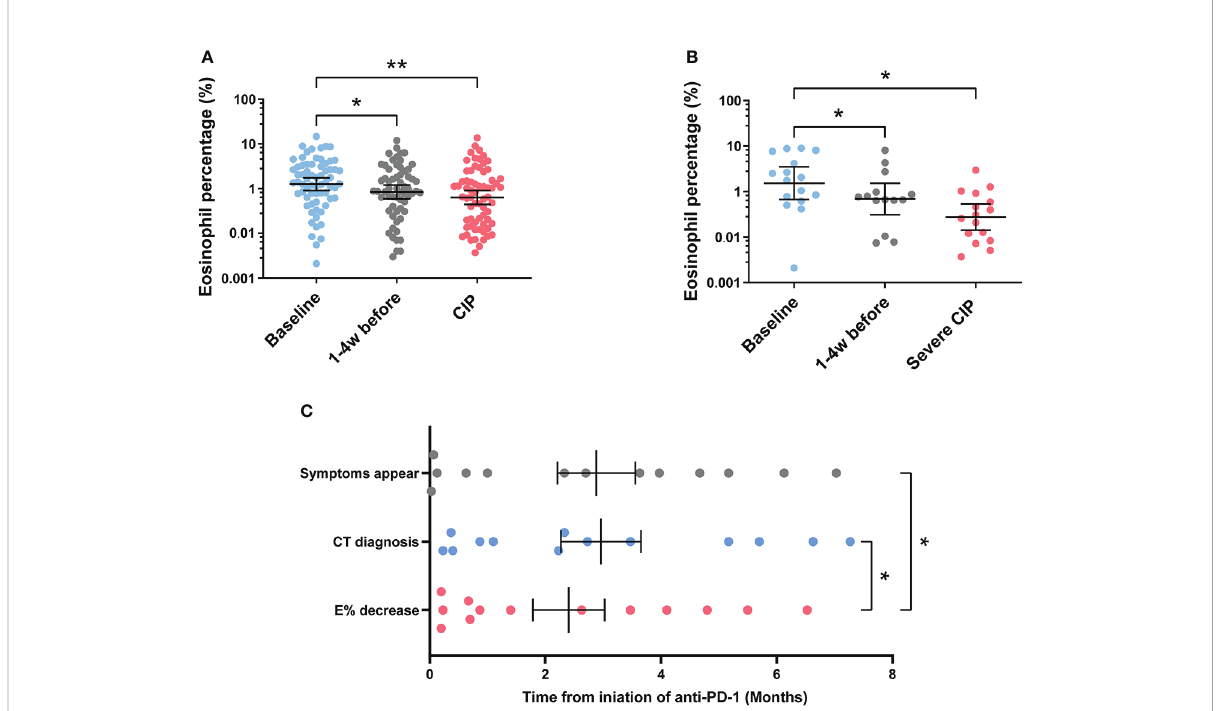
FIGURE 3 Continuous monitoring of eosinophil percentage before the endpoint. (A) Eosinophil percentage at different times before endpoint in patients with CIP. Bars indicate the geometric mean and 95%CI. One-way ANOVA with mixed-effects model followed by Holm – Sidak ’ s post-hoc test. ** p < 0.01, * p < 0.05. (B) Eosinophil percentage at different times before endpoint in patients with severe CIP. Bars indicate the geometric mean and 95%CI. One-way ANOVA with mixed-effects model followed by Holm – Sidak ’ s post-hoc test. * p < 0.05. (C) Timeline of immune checkpoint inhibitor initiation to symptom appearance, CT diagnosis, and eosinophil percentage decrease ( E pre-end < 0.5 E bas ) in patients with severe CIP. Bars indicate the mean and SEM. One-way ANOVA with mixed-effects model followed by Holm – Sidak ’ s post-hoc test. * p < 0.05. CIP, checkpoint inhibitor pneumonitis; CI, con fi dence interval; E pre-end , eosinophil percentage before endpoint; CT, computerized